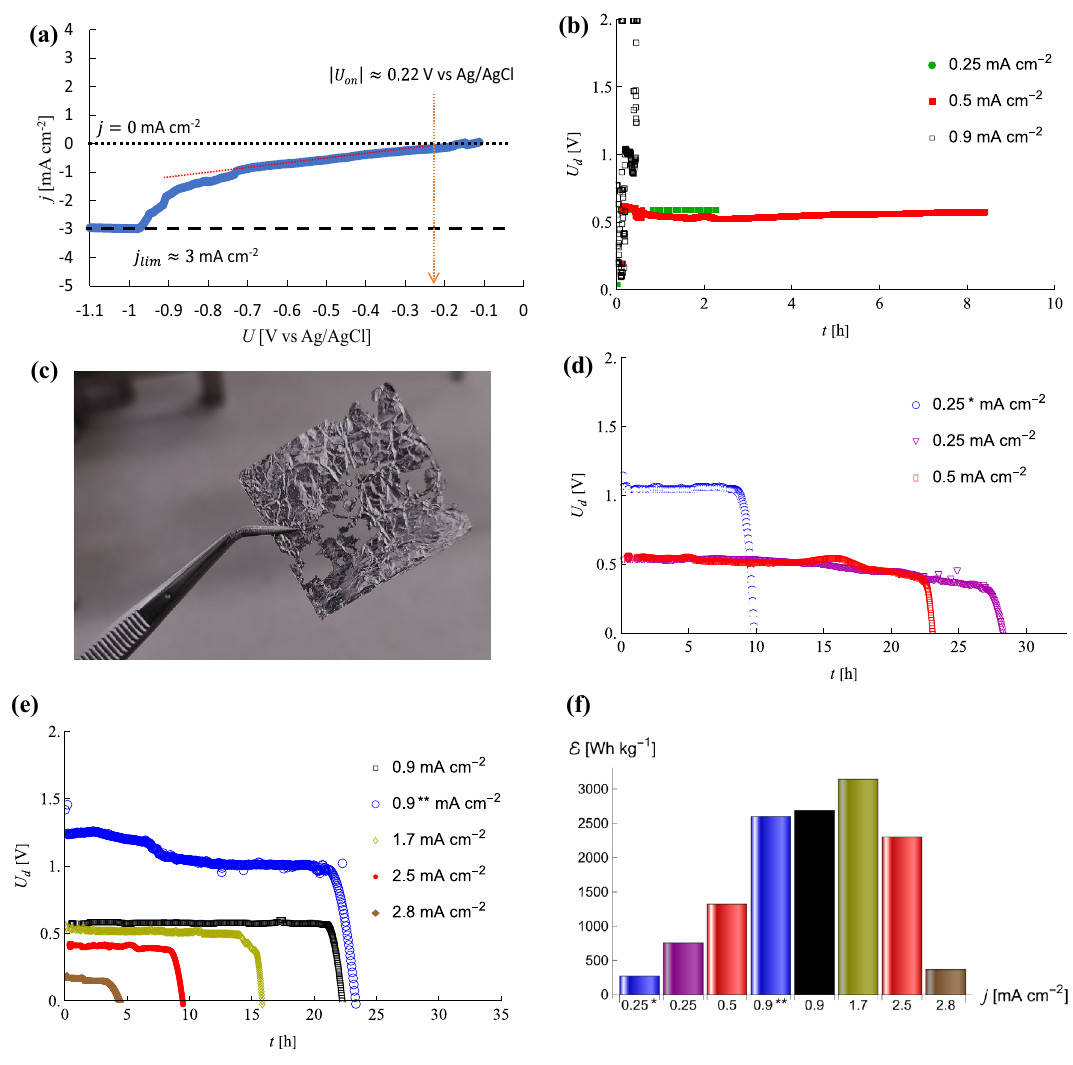
Figure 4. ( a ) LSV curve of the PEDOT:PSS cathode indicating the limiting current for the ORR and the onset potential for oxygen reduction by the catalyst ( b ) Discharge curves of Al-air batteries with golden current collector for different current densities ( c ) Partially consumed aluminium anode ( d ) Discharge curves of Al-air batteries for different low current densities, where, * indicates a non-optimal battery assembly of two batteries in series ( e ) Discharge curves of Al-air batteries with moderate to higher (approaching the limiting current) current densities, where, ** indicates two batteries in series ( f ) Specific energy for several current